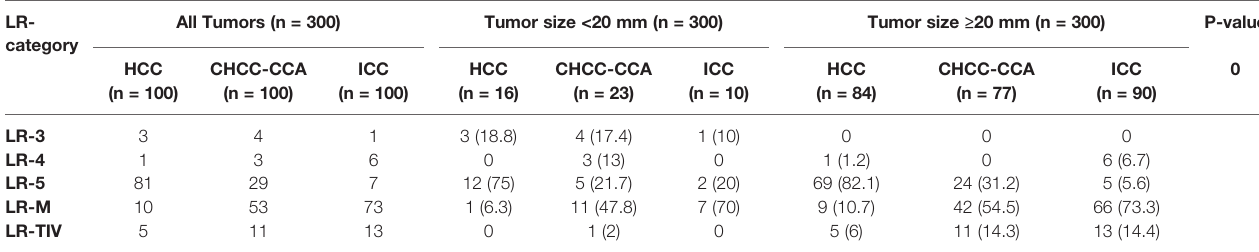
TABLE 3 | Results of LI-RADS categorization of 300 hepatic tumors.